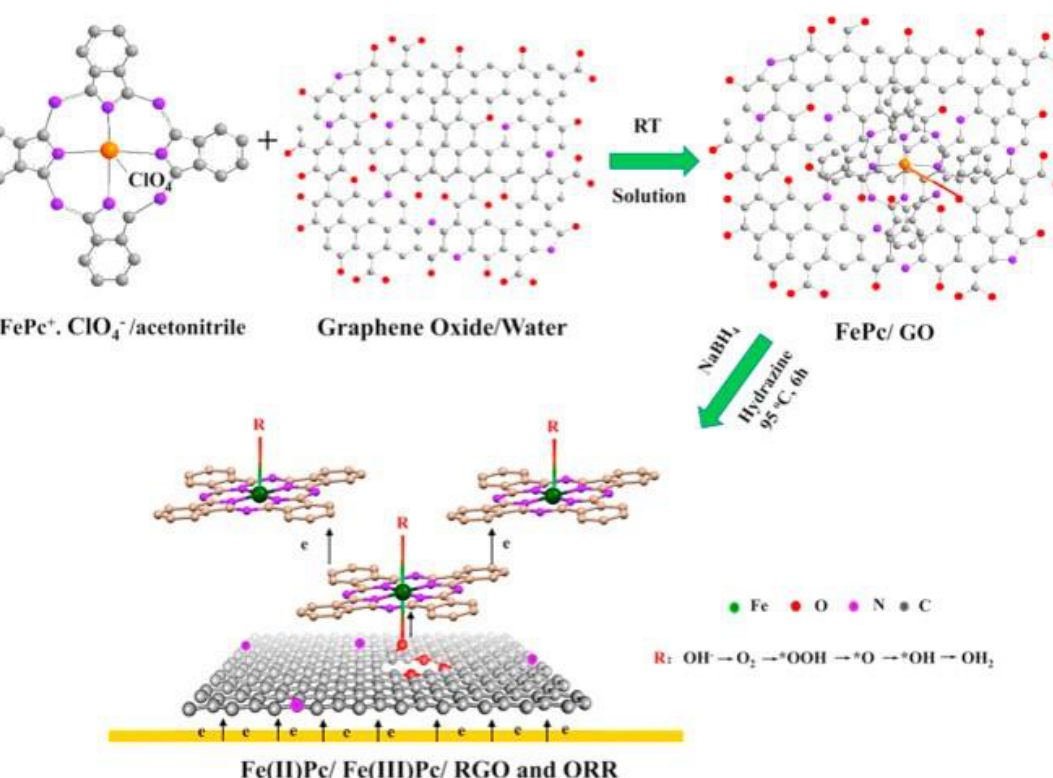
Figure 7. Schematics of the synthesis and catalytic ORR mechanism of Fe(II)Pc / Fe(III)Pc / RGO adapted from ref [52] Copyright 2018 Elsevier.